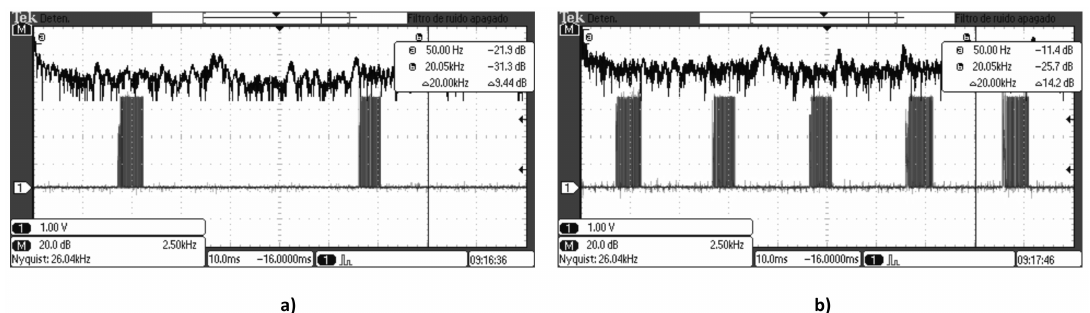
Figure 7. Train of pulses sent by the Touch Controller. Normal signal ( a ) and disturbed signal ( b ).